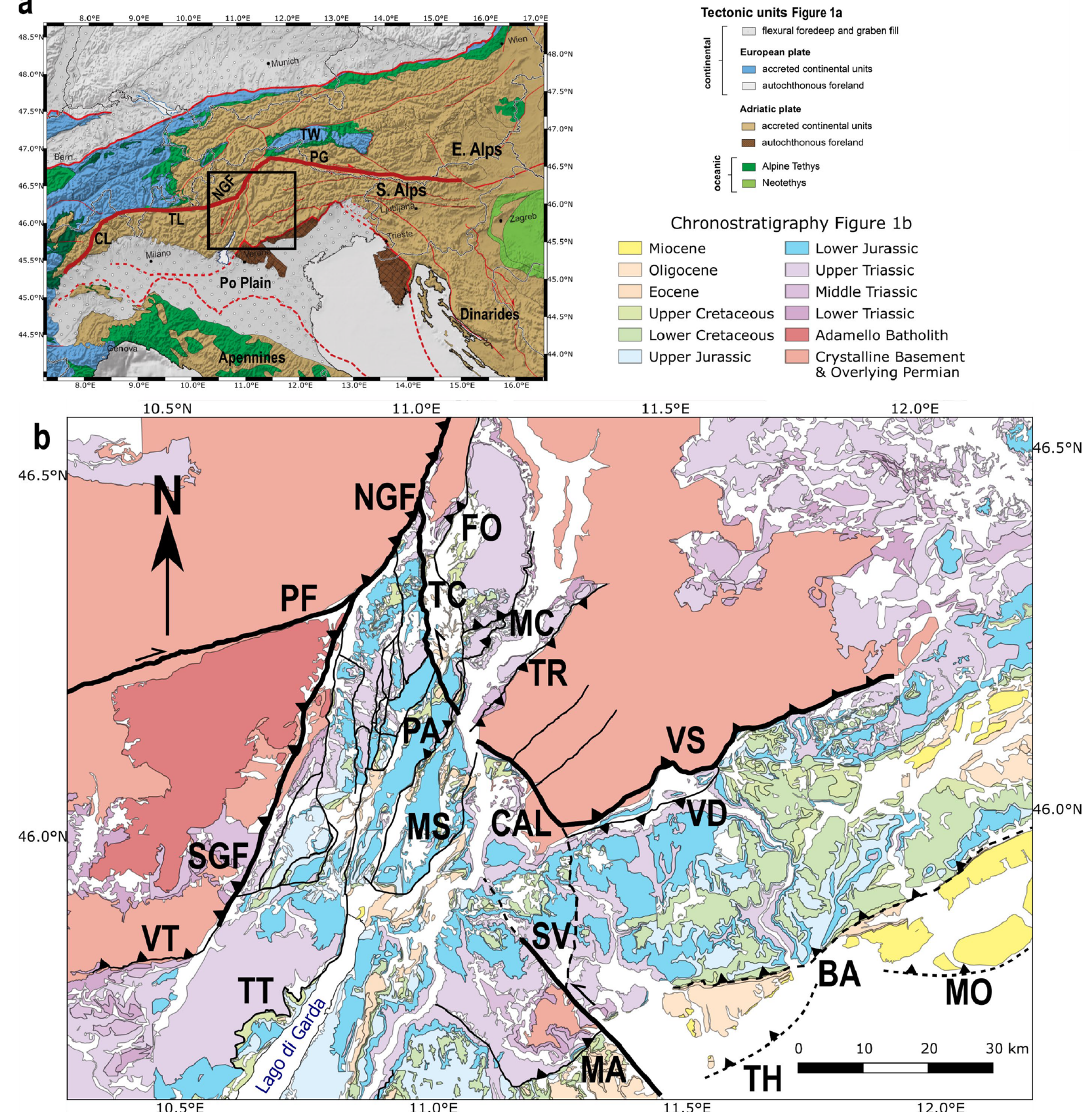
Figure 1. (a) Tectonic provenance map of the Alps (Handy et al., 2010 simplified from Schmid et al., 2004, 2008). The Southern Alps and Dinarides are accreted units derived from the Adriatic plate (brown). The Southern Alps are bounded to the north by the Periadriatic Fault (PF), which is sinistrally offset by the Northern Giudicarie Fault (NGF). The PF is divided into a western segment (Tonale and Canavese Lines, TL and CL, respectively) and eastern segment (Pusteria-Gailtal Line, PG). (b) Geological map of our study area (Giudicarie Belt) in the eastern Southern Alps indicated by a black square in (a) (TW is the Tauern Window). Fault abbreviations are as follows: BA stands for Bassano, CAL stands for Calisio, FO stands for Foiana, MA stands for Marana, MC stands for Mezzocorona, MO stands for Montello, MS stands for Monte Stivo, PA stands for Paganella, SGF stands for Southern Giudicarie, SV stands for Schio-Vicenza, TC stands for Trento- Cles, TH stands for Thiene-Bassano, TR stands for Truden, TT stands for Tremosine-Tignale, VD stands for Val di Sella, VS stands for Valsugana, and VT stands for Val